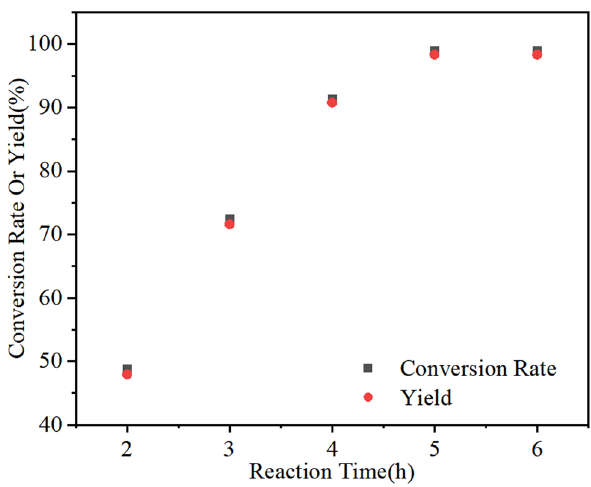
Figure 11: E ff ect of the reaction time on the ε - caprolactone yield. Reaction conditions: cyclohexanone ( 0.02 mol ) , benzaldehyde ( 0.06 mol ) , 1,2 - dichloroethane ( 30 mL ) , Fe – Sn – O ( 0.12 g ) , O ( 20 mL min − 1 ) ,